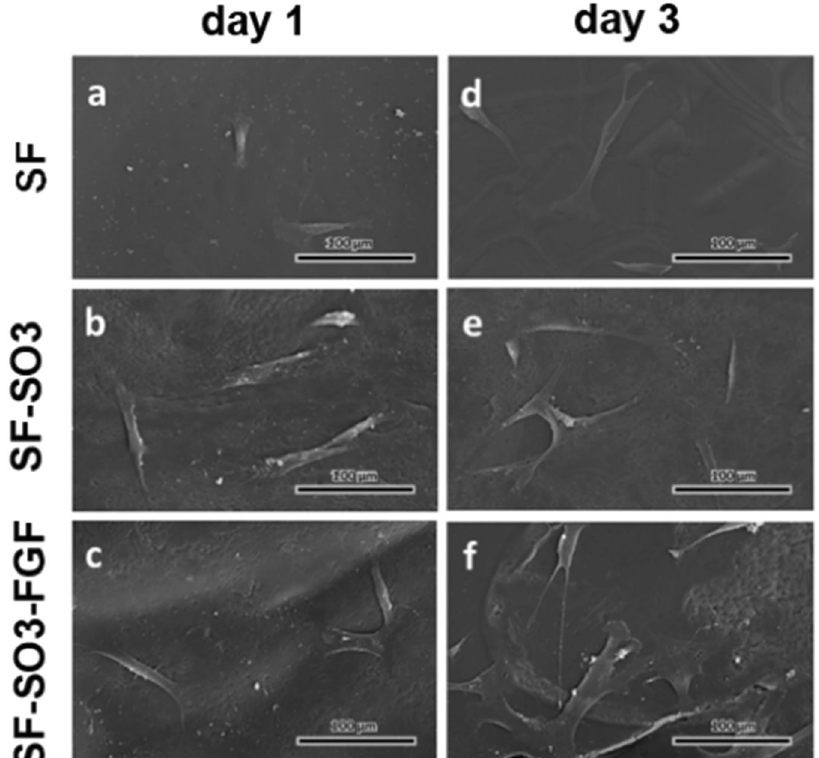
Figure 3. Morphology of CFFs cultured on pure SF scaffolds ( a and d ), sulfated SF (SF-SO 3 ) scaffolds ( b and e ) and FGF-2 incorporated sulfonated SF (SF-SO 3 -FGF) scaffolds ( c and f ) at day 1 and day 3. Magnification = 400X. n = 3; Scale bars, 100 μ